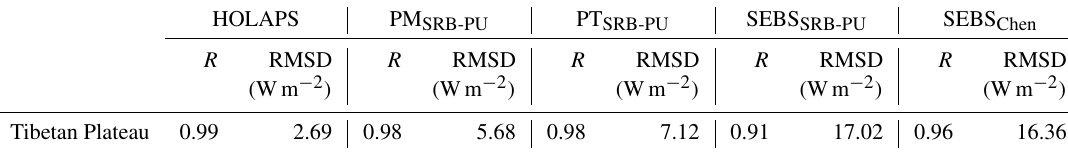
Table 3. Statistics of the LE comparisons between the LandFlux-EVAL benchmark product and other products over the whole TP. HOLAPS